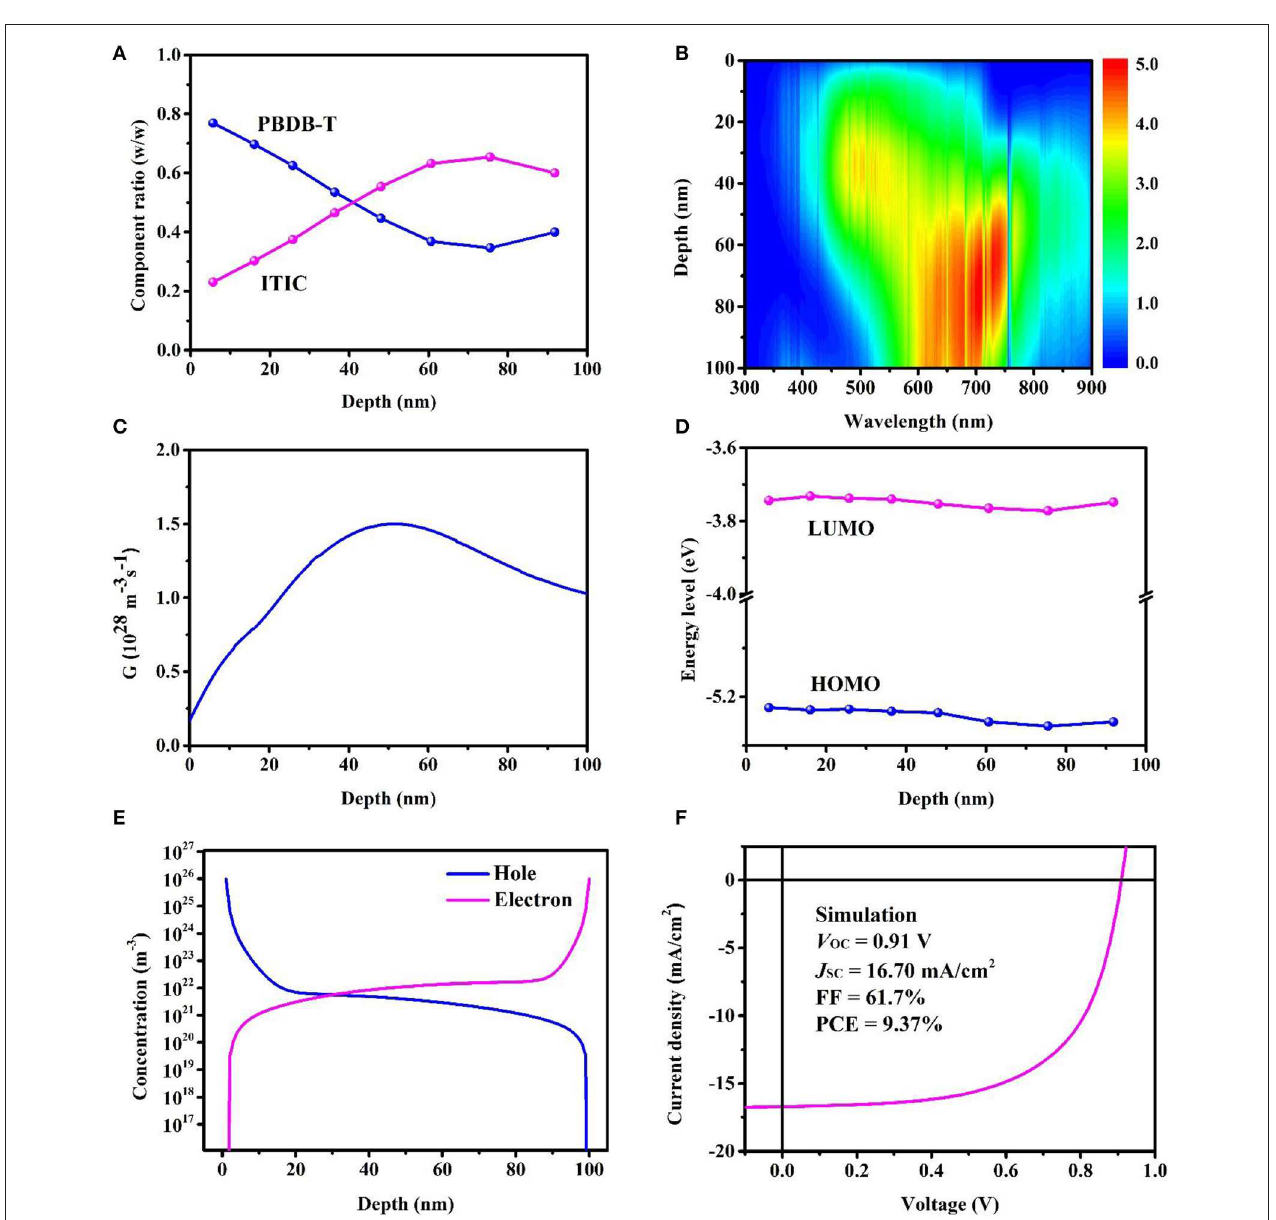
FIGURE 6 | Film-depth-dependent optical and electronic properties of bulk heterojunction (BHJ) devices; 0 and 100nm refer to active layer/MoO 3 and ZnO/active layer interfaces, respectively. (A) Composition distribution profiles of donor and acceptor, as extracted from film-depth-dependent light absorption spectra (FLAS). (B) Exciton generation contour at wavelength and film depth direction (unit, 10 25 m − 3 s − 1 nm − 1 ). The noise-like vertical lines are caused by the fluctuation of real solar spectrum (AM 1.5G). (C) Exciton generation profile at film depth direction calculated from (B) . (D) Film-depth-dependent energy levels {highest occupied molecular orbital (HOMO) of Poly{(2,6-(4,8-bis(5-(2-ethylhexyl)thiophen-2-yl)-benzo[1,2-b:4,5-b ′ ]dithiophene))-alt-(5,5-(1 ′ ,3 ′ -di-2-thienyl-5 ′ ,7 ′ -bis(2-ethylhexyl)benzo[1 ′ ,2 ′ -c:4 ′ , 5 ′ -c ′ ]dithiophene-4,8-dione))} (PBDB-T) and lowest unoccupied molecular orbital (LUMO) of 3,9-bis{2-methylene-[3-(1,1-dicyanomethylene) -indanone]}-5,5,11,11-tetrakis(4-hexylphenyl)-dithieno[2,3-d:2 ′ ,3 ′ -d ′ ]-s-indaceno[1,2-b:5,6-b ′ ]dithiophene (ITIC)}, as approximately obtained from FLAS. (E) Simulated film-depth-dependent carrier concentration distribution. (F) Simulated J-V characteristic curve, using film-depth-dependent optical (B) and electronic (D) properties, both of which are extracted from FLAS.